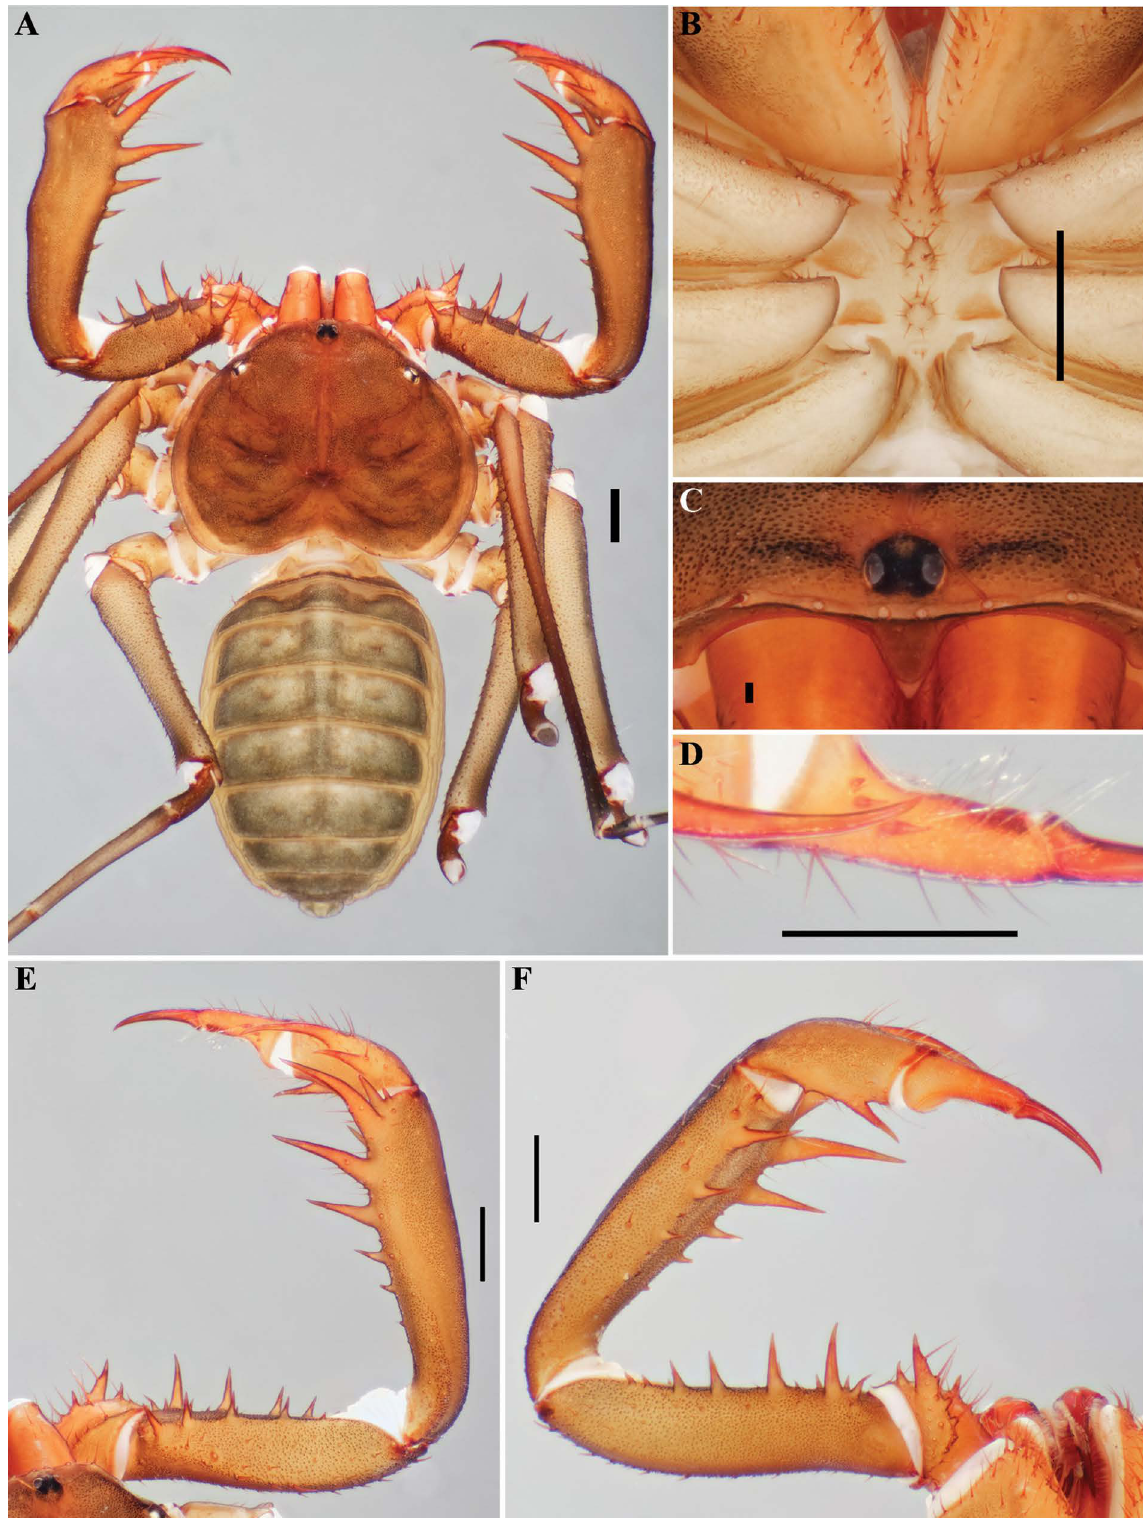
Fig. 126. Sarax tiomanensis sp. nov. (AMCC [LP 12001), general morphology, ♂. A . Habitus, dorsal view. B . Sternum, ventral view. C . Frontal process. D . Pedipalp tarsus, frontal view. E . Pedipalp, dorsal view. F . Pedipalp, ventral view. Scale bars: A–B, D–F = 1 mm; C = 0.1